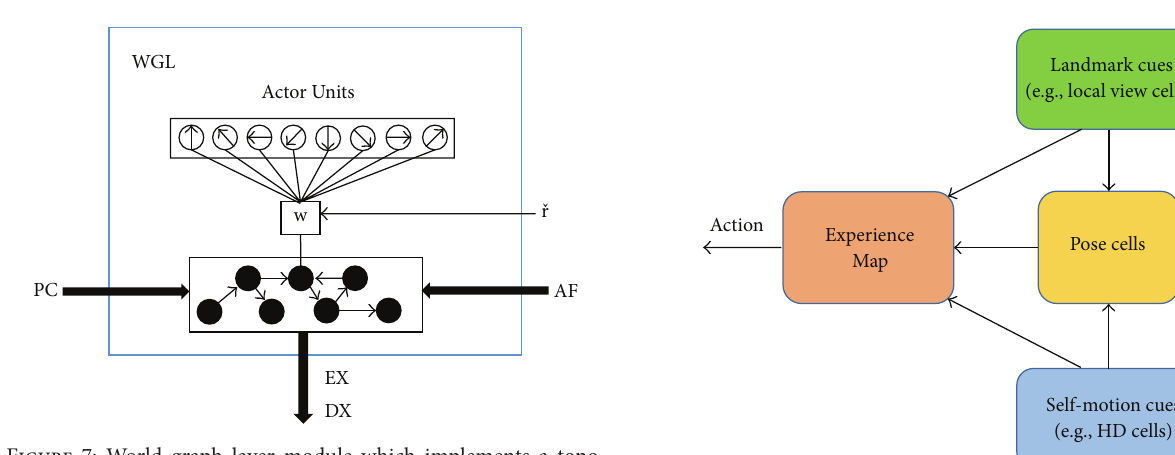
Figure 7: World graph layer module which implements a topo- logical map of the mobile robot’s environment inside the Place Representation module. Figure 8: Connectivity diagram of the RatSLAM, version